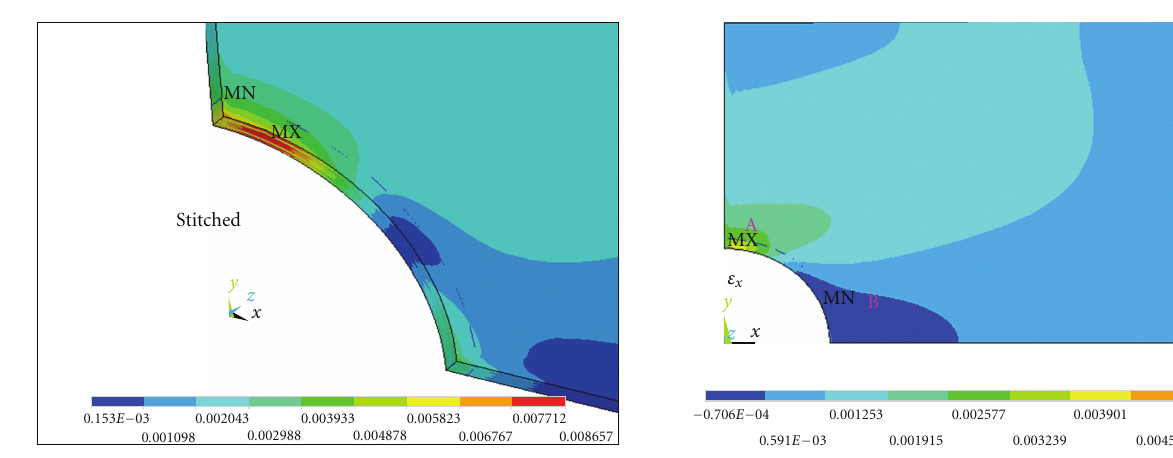
Figure 10: Mises strain distribution of the single-line stitching model.